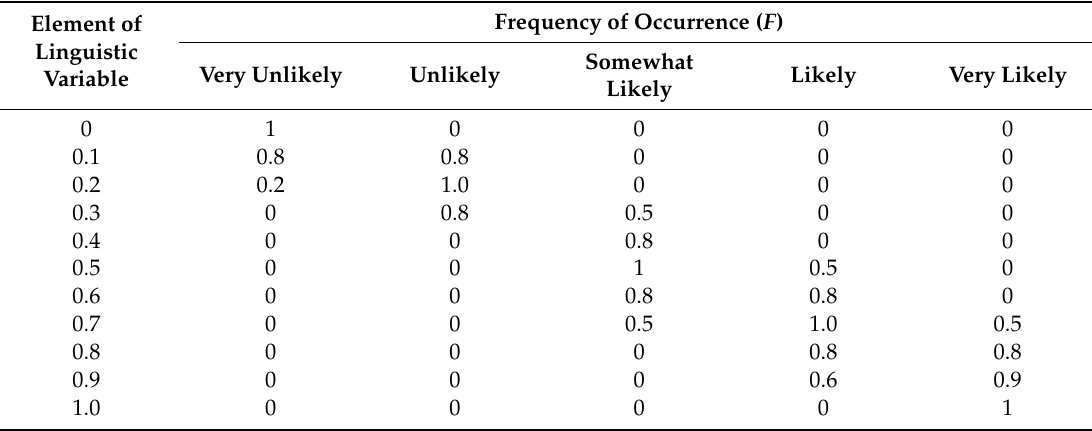
Table 2. Membership function for frequency of occurrence ( F